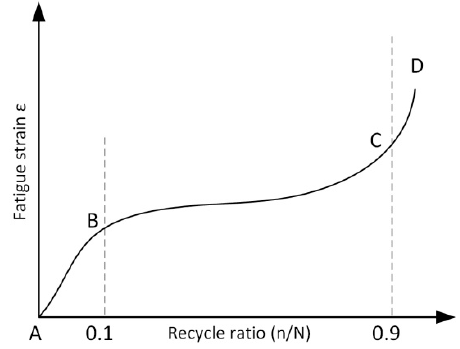
Figure 10. Maximum fatigue deformation cycle ratio curve diagram.